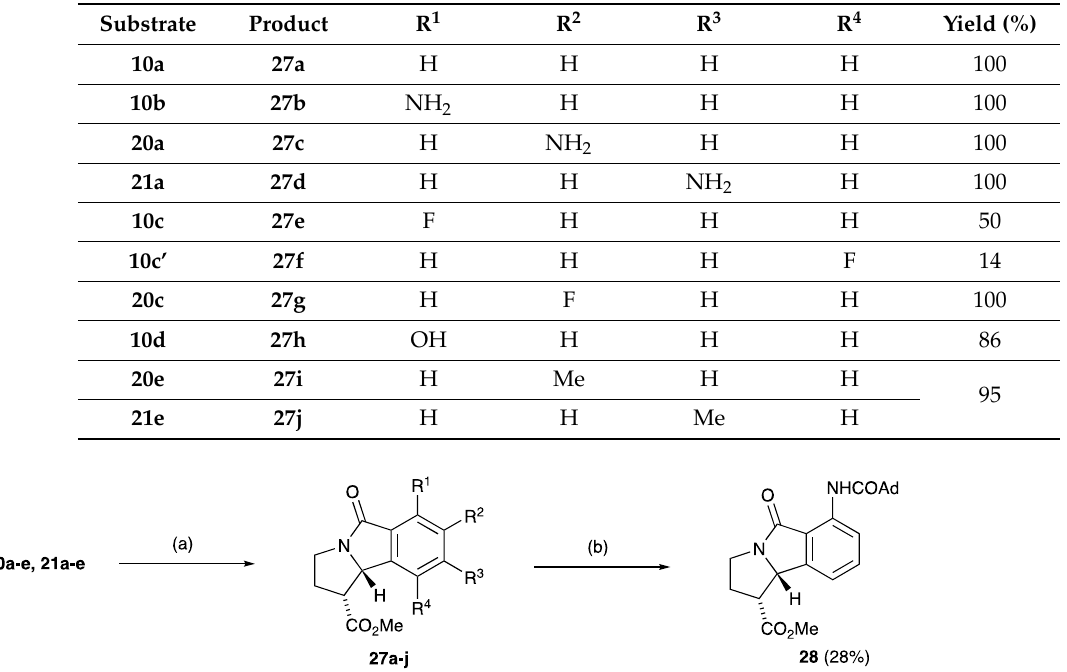
Table 2. Reduction of unsaturated bicyclic lactams 10a – d , 20a – e , 21a – e .